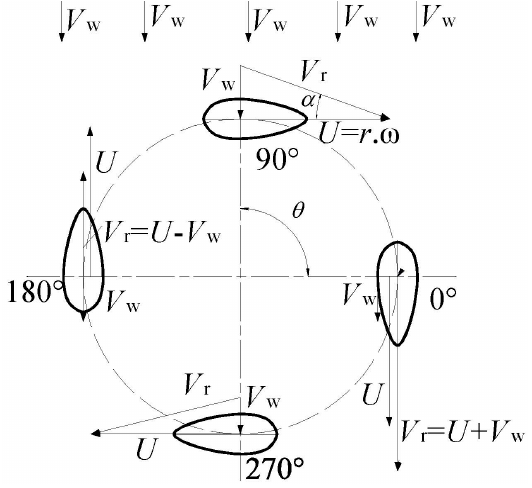
Figure 1. Illustration of Darrieus rotor.